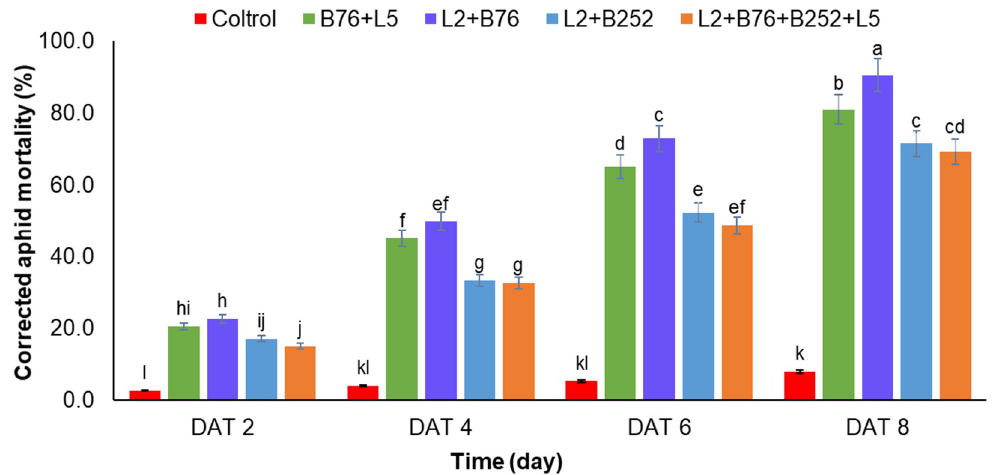
Figure 2. The mortality of Megoura japonica by the binary combinations from strains of Verticillium lecanii and Beauveria bassiana (L2 + B76, B76 + L5, L2 + B252, L2 + B76 + B252 + L5, and control) recorded at di ff erent time intervals. Columns show the bean aphid mortality with di ff erent fungal strains ± SE ( n = 50). The di ff erent letters express the significant di ff erence between di ff erent treatments (two-way factorial analysis of variance (ANOVA); least significant di ff erence (LSD) test at α = 0.05). DAT: Days after treatment. Table 2. Analysis of variance (ANOVA) for the mortality of M. japonica by the binary combinations from four fungal strains of V. lecanii and B. bassiana at different time intervals. Source of Variation DF Sums of Squares Mean Squares F Ratio Prob